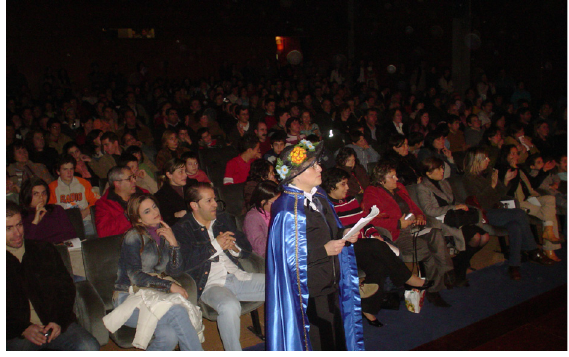
6 | Fig. 6: The author presenting the Intercultural Music Festival.